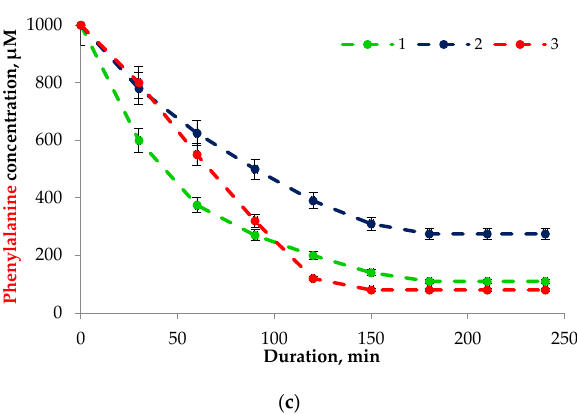
Figure 3. The phenylalanine concentration dynamics in a model medium (imitating blood serum) containing enzymes with activity ( a ) 1.5 U/mg; ( b ) 3.0 U/mg; ( c ) 5.0 U/mg depending on incubation duration: 1—PAH; 2—phenylalanine transaminase; 3—encapsulated L-phenylalanine ammonia-lyase. The experiments were carried out in triplicate. The results of determining the content of phenylalanine metabolism products after incubation of model solutions with enzymes are presented in Table 2. Table 2. Results of determination of the content of phenylalanine metabolism products after incubation of model solutions with enzymes. Incubation Duration, min The Concentration of Phenylalanine Metabolic Products, µ